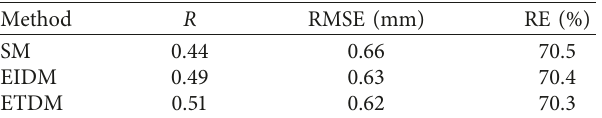
Table 3: Statistics of correlation coefficient ( R ), root-mean-squared error (RMSE), and relative error (RE) that evaluate the perfor- mance of the three methods to derive RQPE during December 2017.